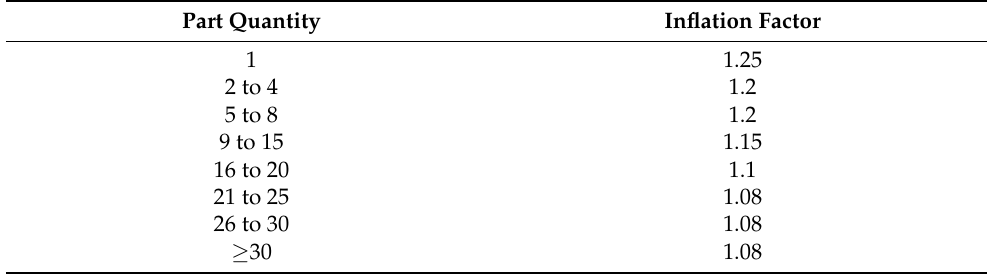
Table 5. Inflation factors applied to machining operation estimated times for different part